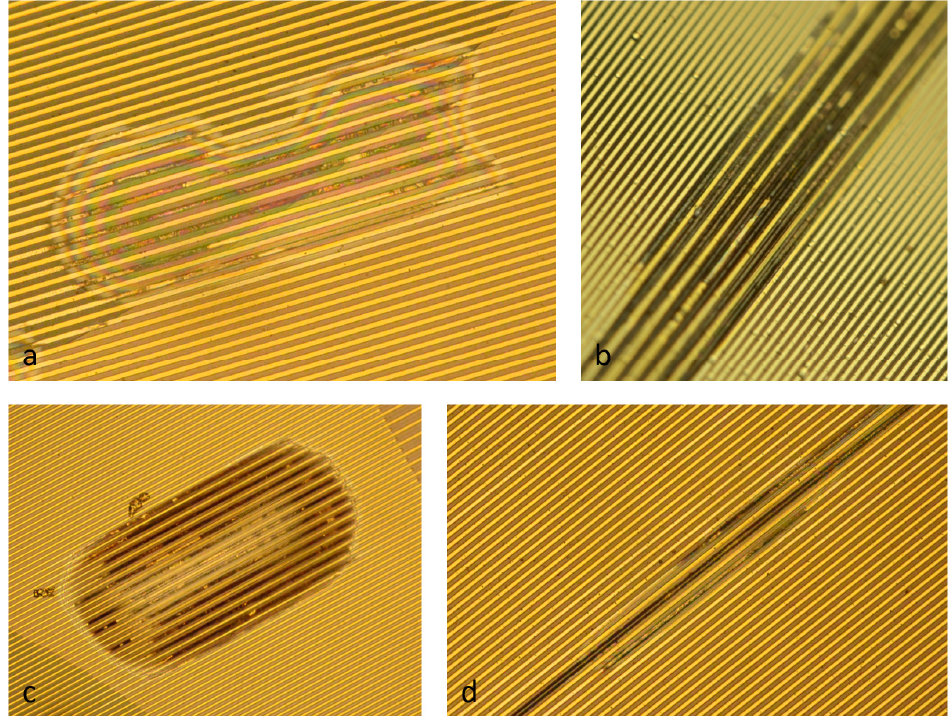
Figure 7. Microscope top view images of defect examples after the long-term test: ( a ) delamination occurred at the membrane transition and gold layer dissolved at anode electrode; ( b ) corrosion of gold layer on the PI membrane; ( c ) delamination and gold corrosion outside the membrane; ( d ) narrow delamination and gold corrosion.